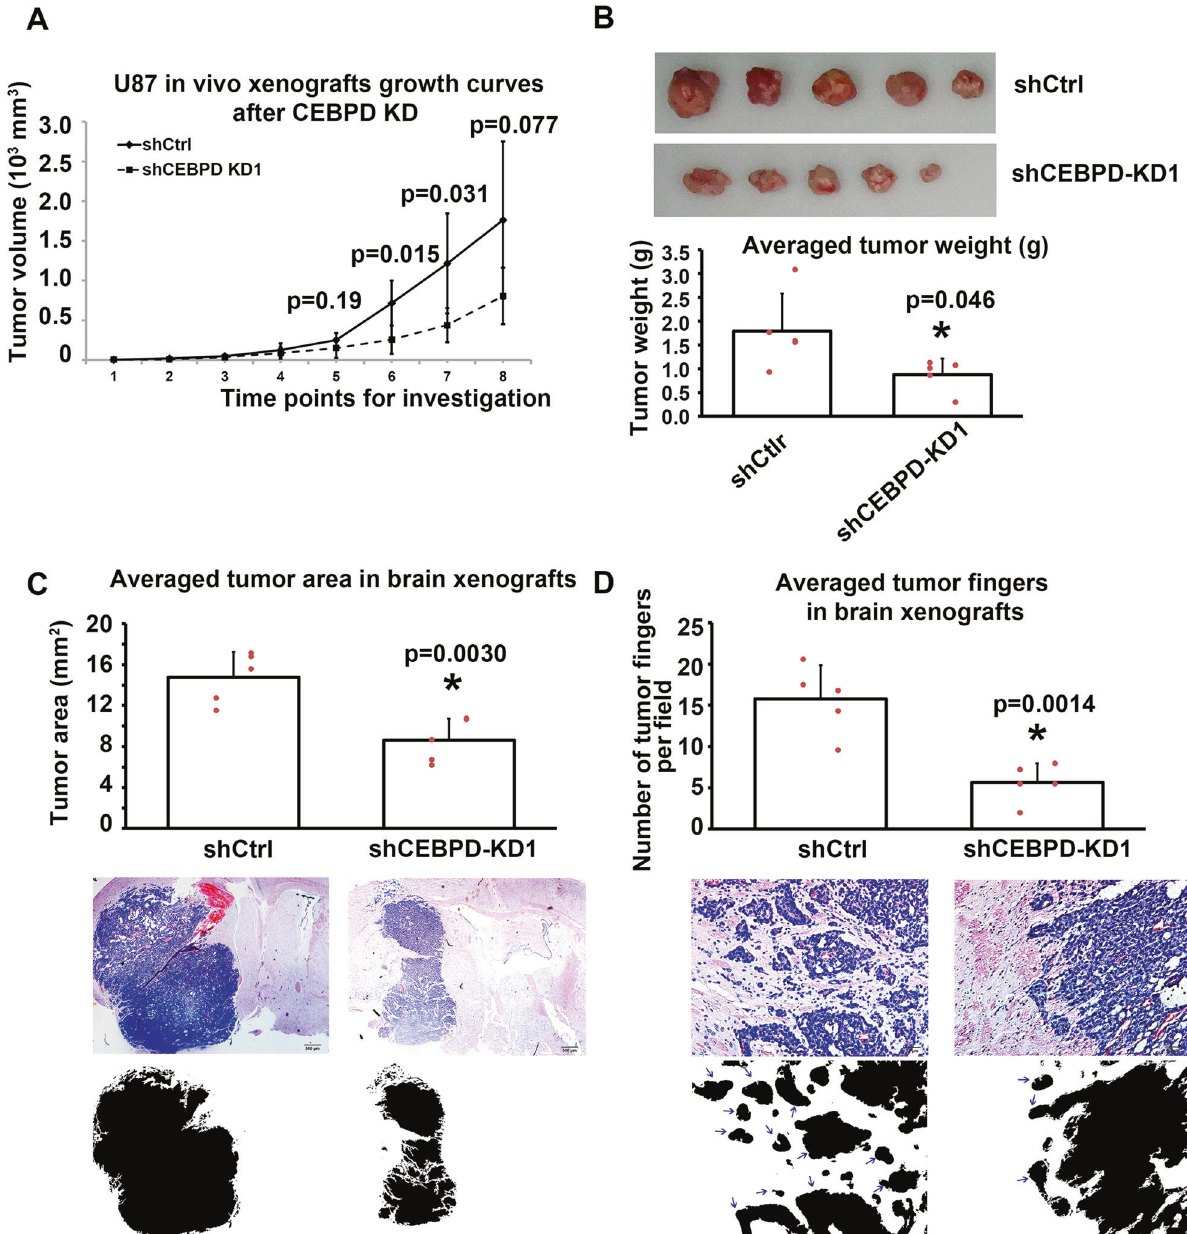
Fig. 4 CEBPD knockdown inhibited xenograft tumor growth and invasion capacity of GBM cells in vivo. A , B Flank xenograft experiments showing the in vivo growth curves of U87 cells in shCtrl ( n = 5) and shCEBPD groups ( n = 5). C Intracranial xenografts tumor showing the tumor volumes in shCtrl ( n = 5) and shCEBPD KD ( n = 5) groups. The bottom binary images showed the tumor areas. D The invasion capacity of U87 cells in vivo in shCtrl and shCEBPD KD groups was evaluated by examining the number of tumor fi ngers in per fi eld. The bottom binary images showed the tumor areas, where islands and protruded areas were indicated by arrows. * p < 0.05, compared with shCtrl